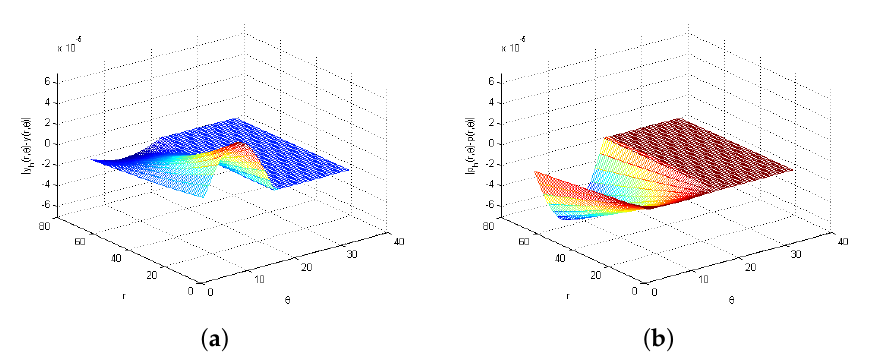
Figure 11. Error for state y ( a ) and adjoint state p ( b ) with N = 64.